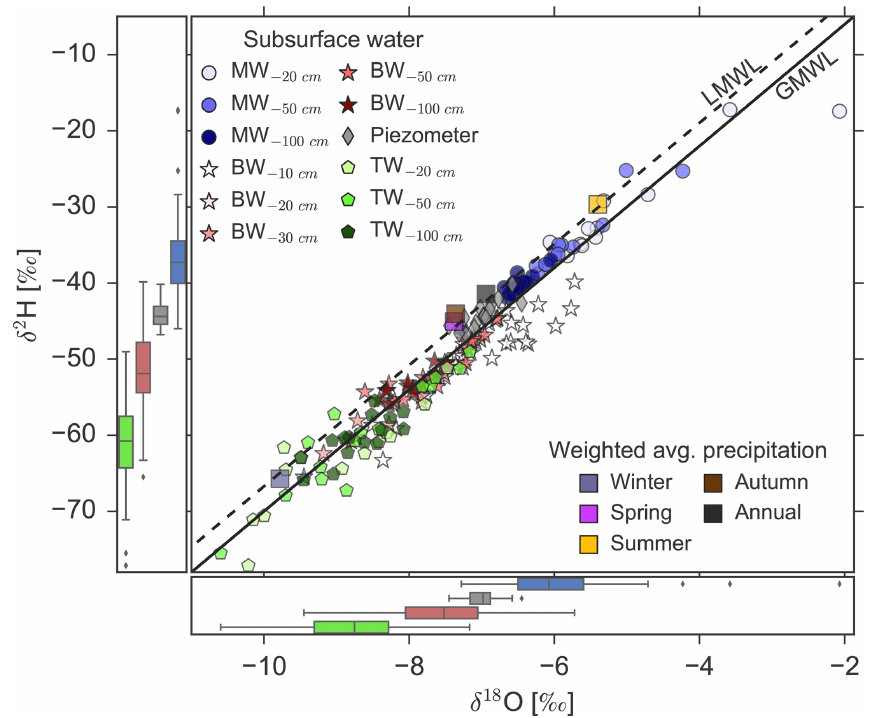
Figure 4. Water isotopes ( δ 2 H and δ 18 O) of mobile water (MW) and bulk soil water (BW) as well as piezometer water. We further show weighted seasonal and annual averages of rainfall stable isotopes (squares), the local meteoric water line (LMWL; δ 2 H = 7.96 δ 18 O + 12.89‰), the global meteoric water line (GMWL; δ 2 H = 8 δ 18 O + 10‰), and the mass-balance-derived tightly bound water (TW). The box and whisker plots represent the mean (black line), the interquartile (box), the range (whiskers), and the outliers (black dots) of all MW (blue), piezometer (grey), BW (red), and TW (green) water samples.